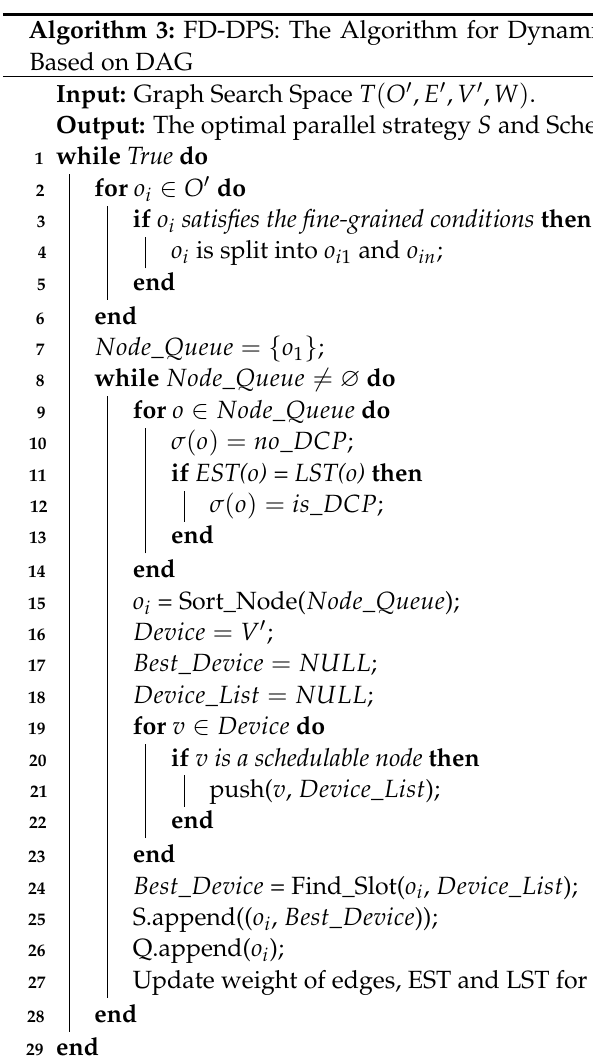
Algorithm 3: FD-DPS: The Algorithm for Dynamic Critical Path Generation Based on